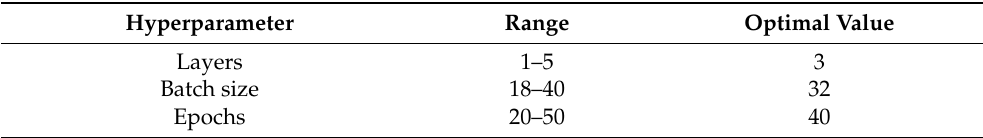
Table 1. Selected hyperparameters and corresponding range to find the optimal values for a lightweight 1D-CNN